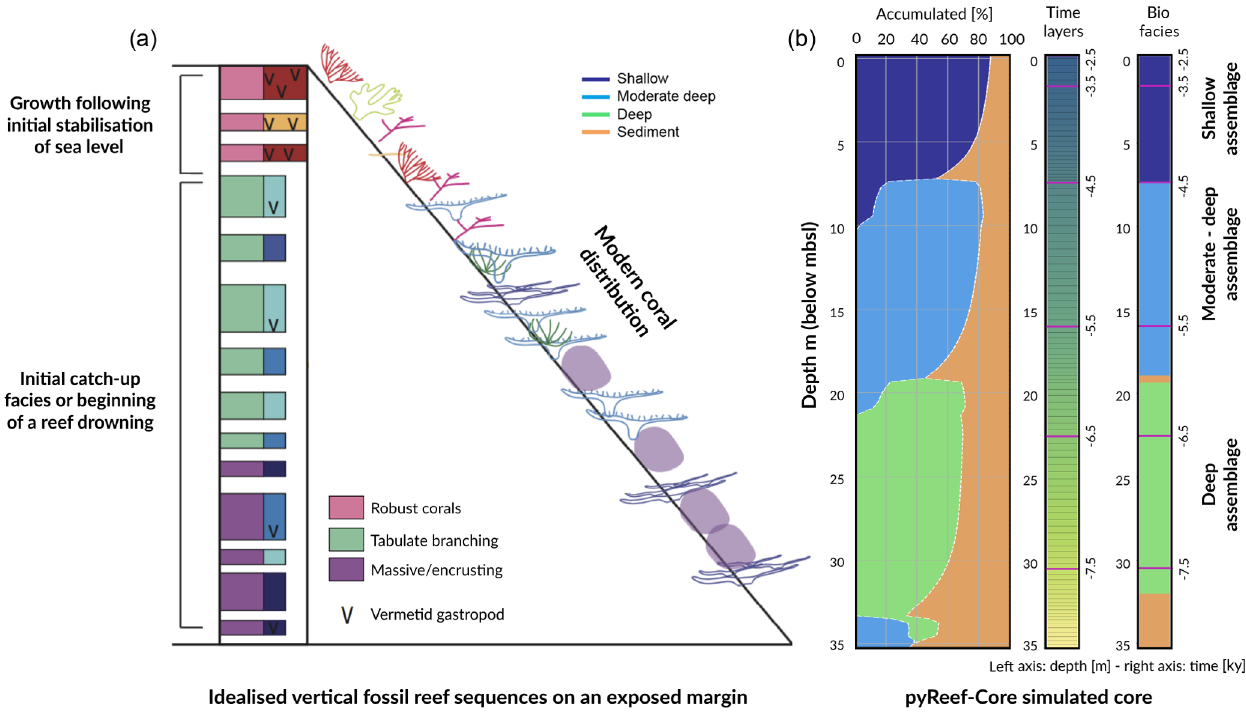
Figure 5. (a) Ideal shallowing-up fossil reef sequence representing a catch-up growth strategy with associated assemblage compositions and changes, adapted from Dechnik (2016); (b) model output of produced pyReef-Core sequence representing a similar shallowing-upward, catch-up phase.